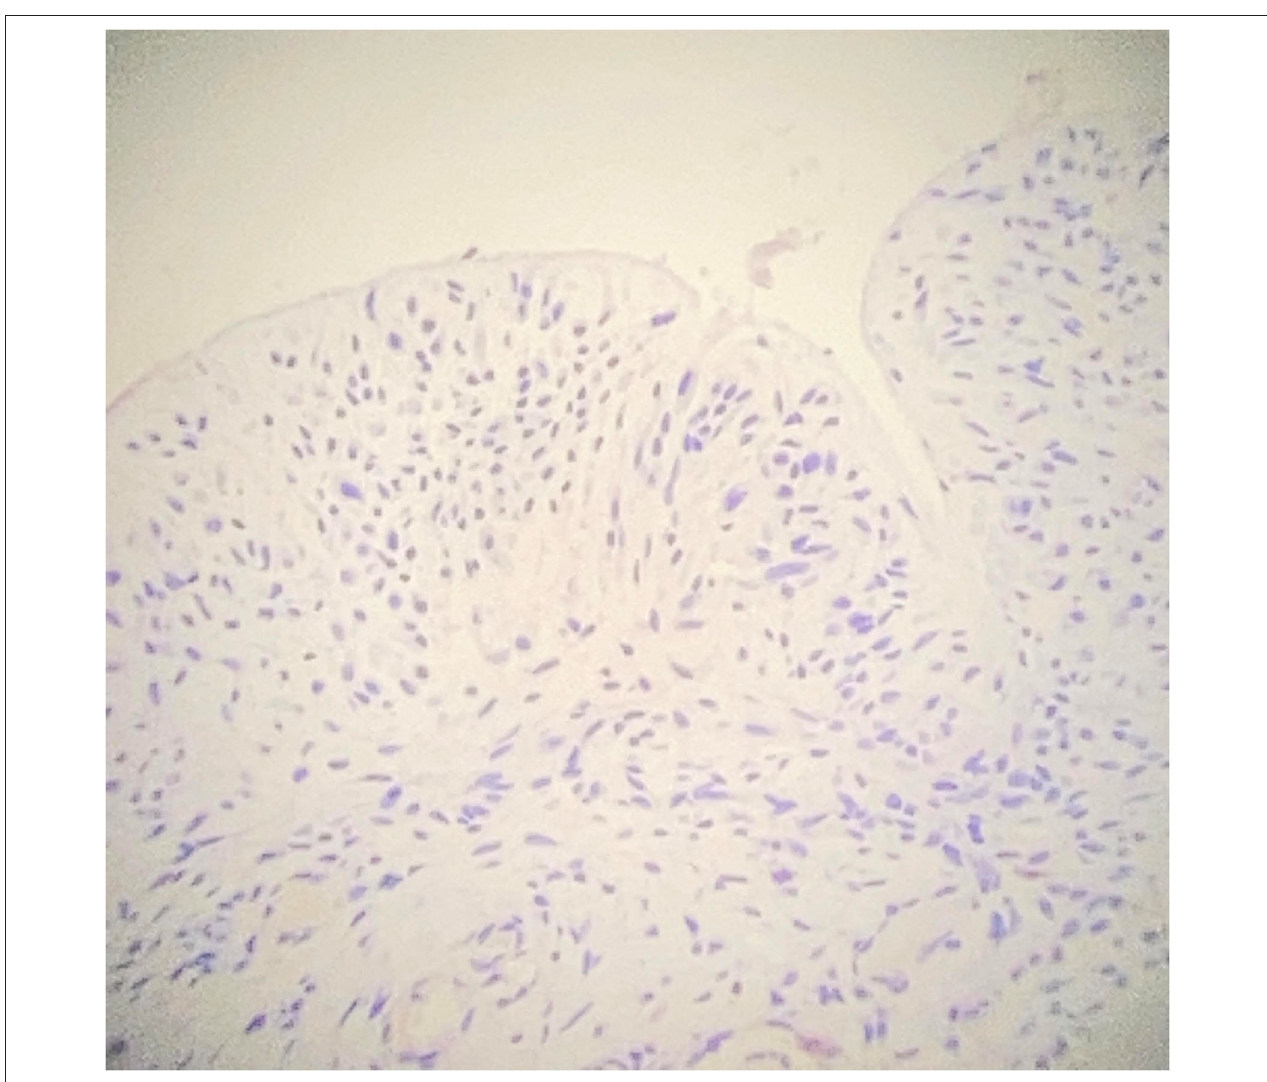
FIGURE 1 | Immunohistochemical (IHC) study of periprothestic staining. CD30 negative staining on periprosthetic capsule (original magnification 10 ×